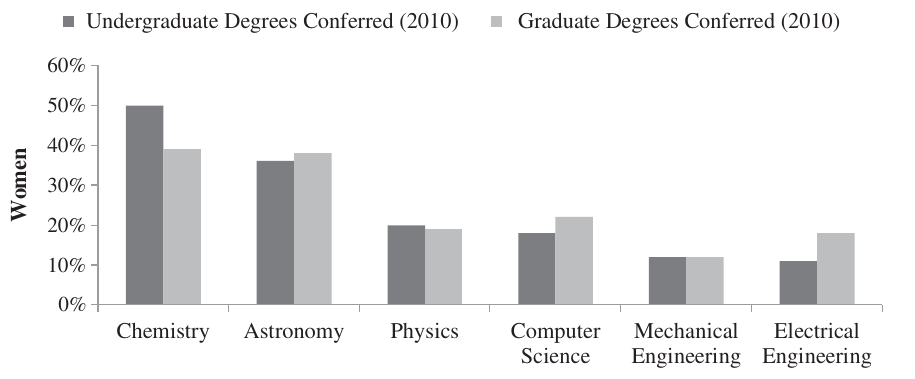
FIG. 1. Percent of women being conferred degrees in the physical sciences at the time of the interviews [14].